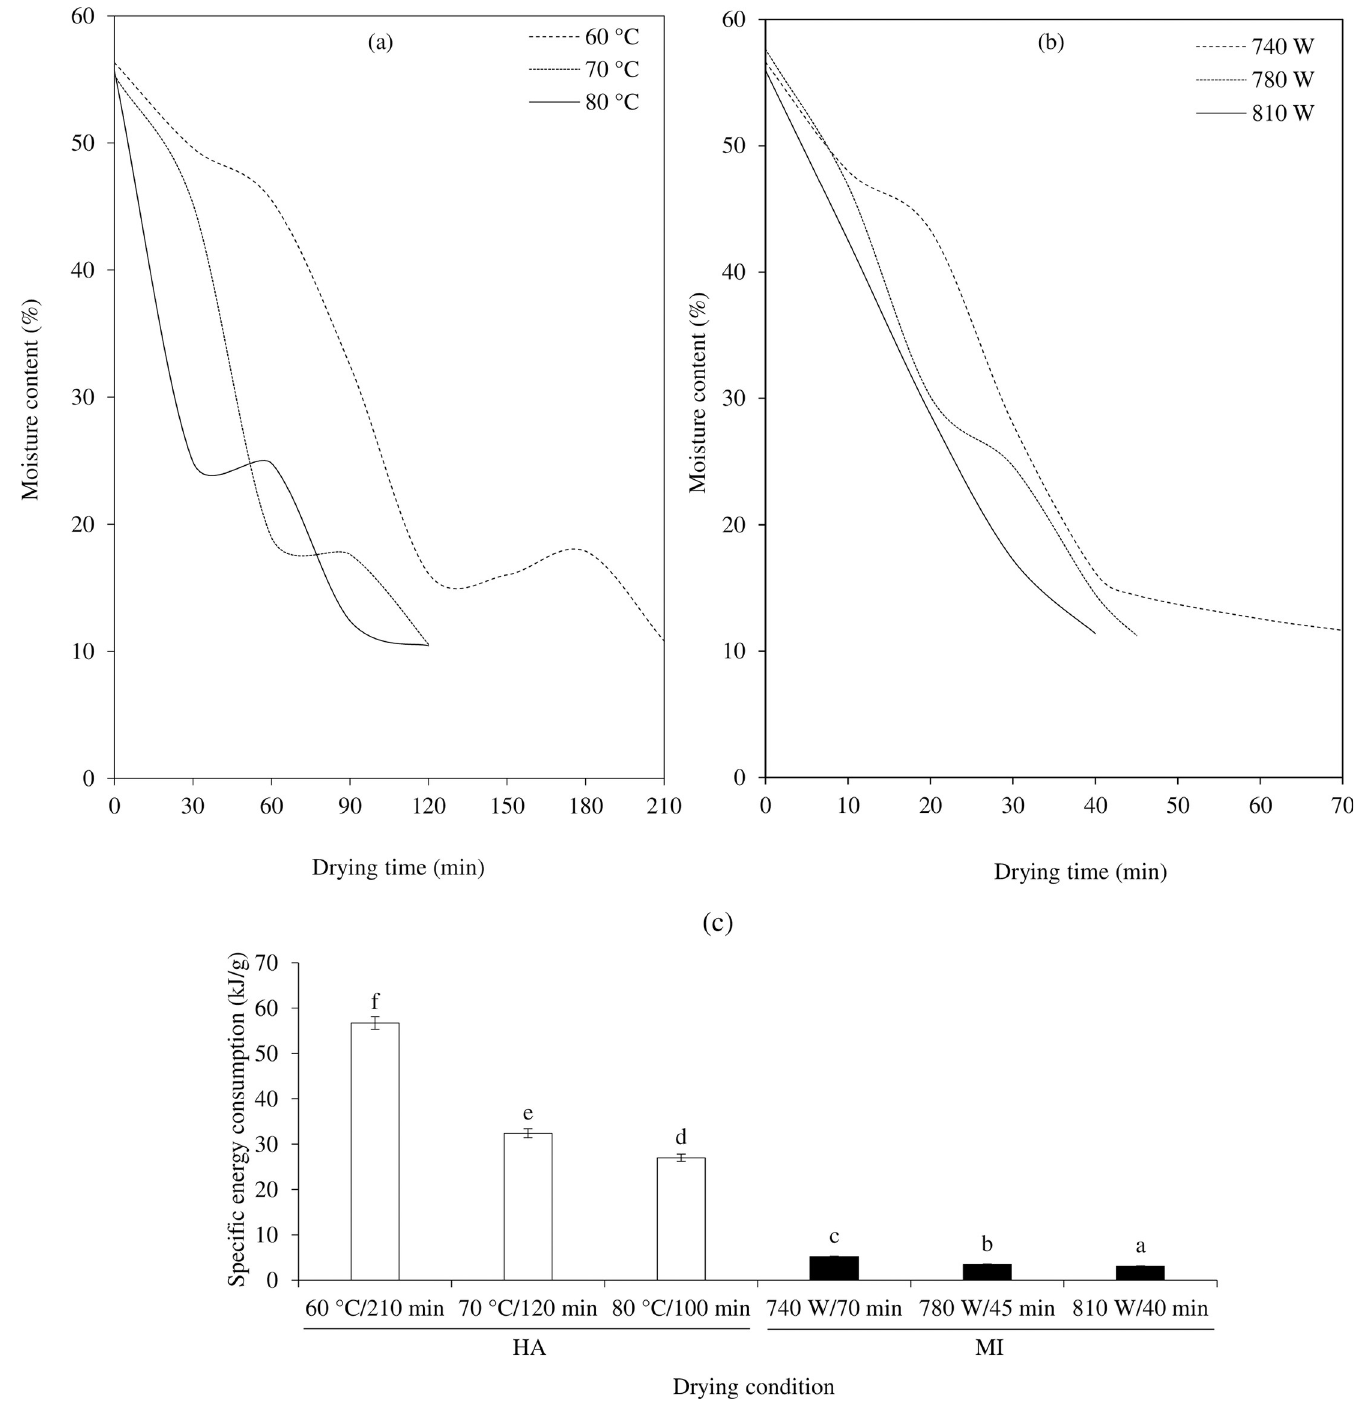
Fig 2. Drying curves of Tai-Pla curry powder (TCP) dried using hot air (HA) (a) and hybrid microwave-infrared drying (MI) (b) under different drying conditions.